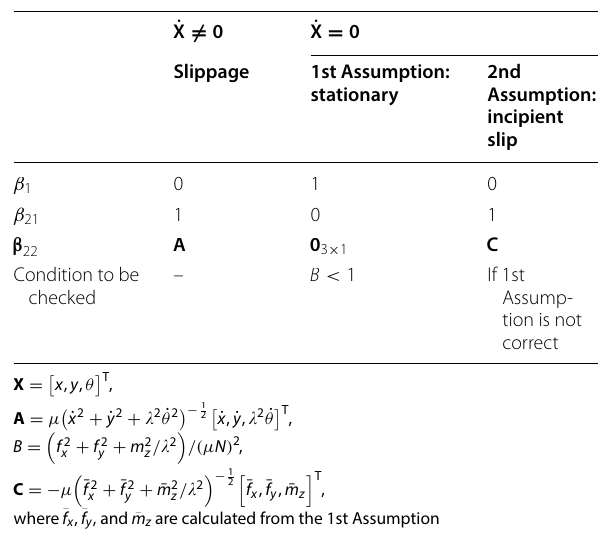
Table 1 Parameters β 1 , β 21 , and β 22 in different states of planar contact